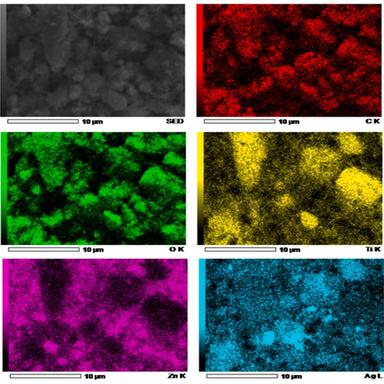
EDX mapping analysis of GO@TiO2.ZnO.Ag HNM.